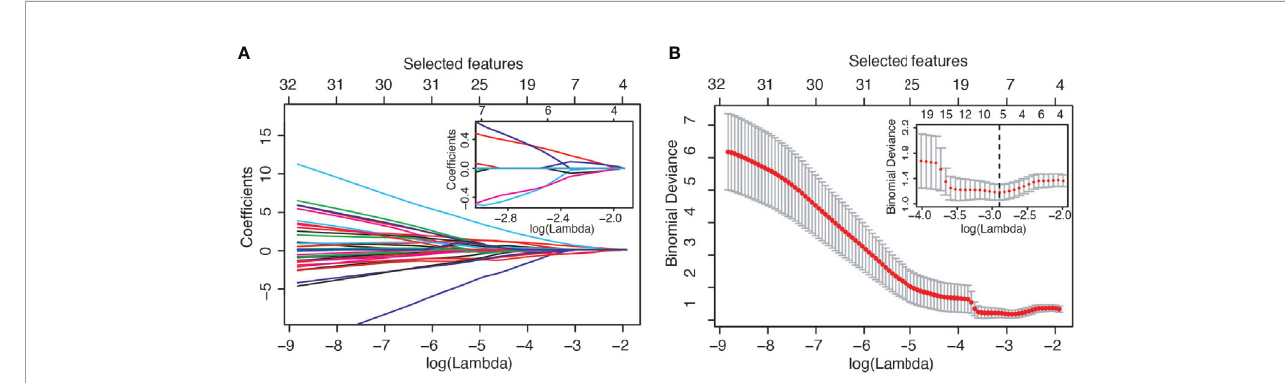
FIGURE 1 | LASSO variable selection process. (A) Values of the LASSO regression coef fi cient as a function of log (Lambda). (B) LOOCV deviance as a function of log (Lambda) and therefore of the number of selected